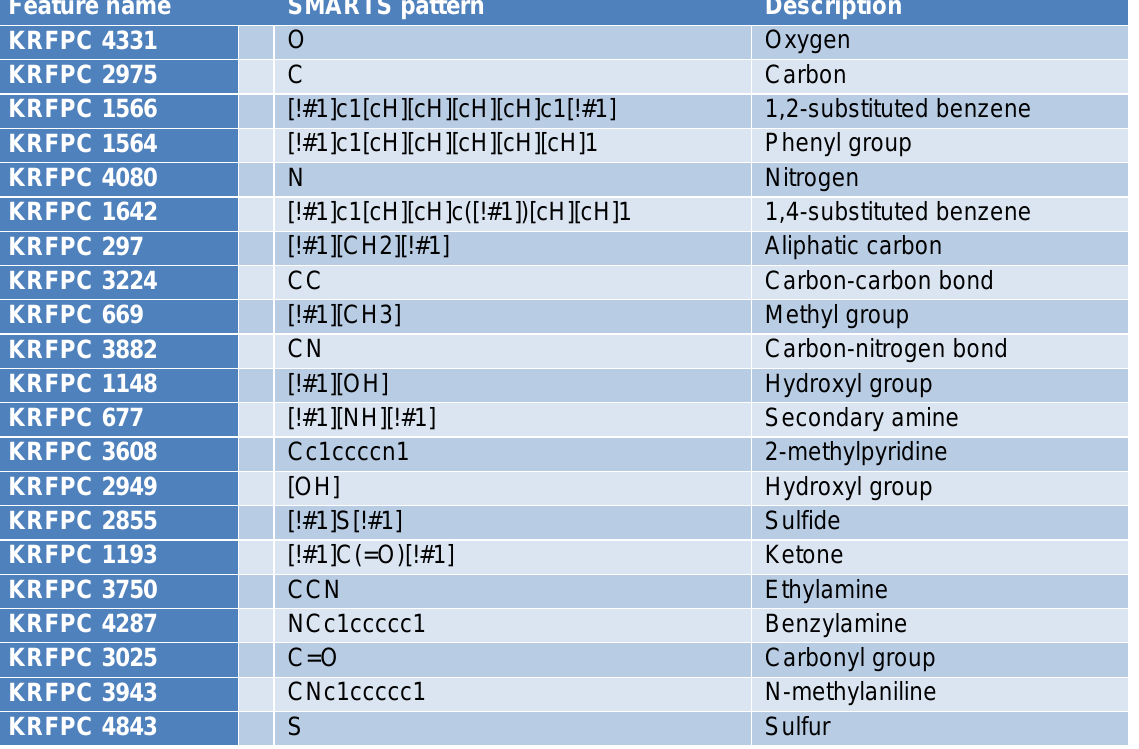
Table 6: Feature importance from RF model built using KlekotaRothCount